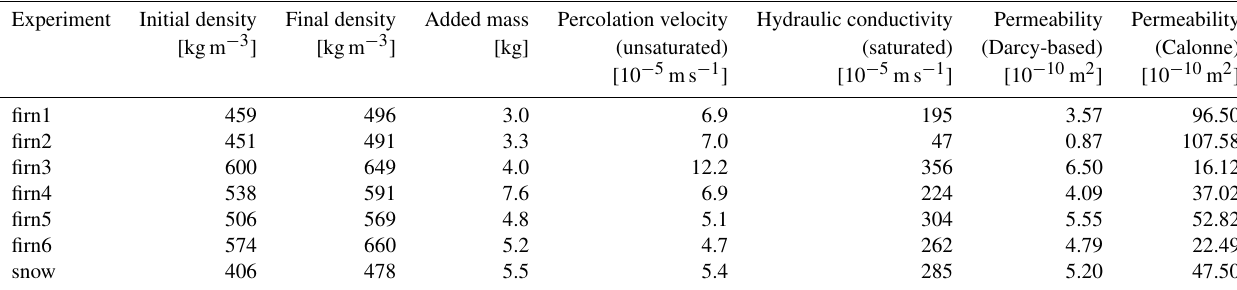
Table 2. Measured and calculated parameters for the percolation